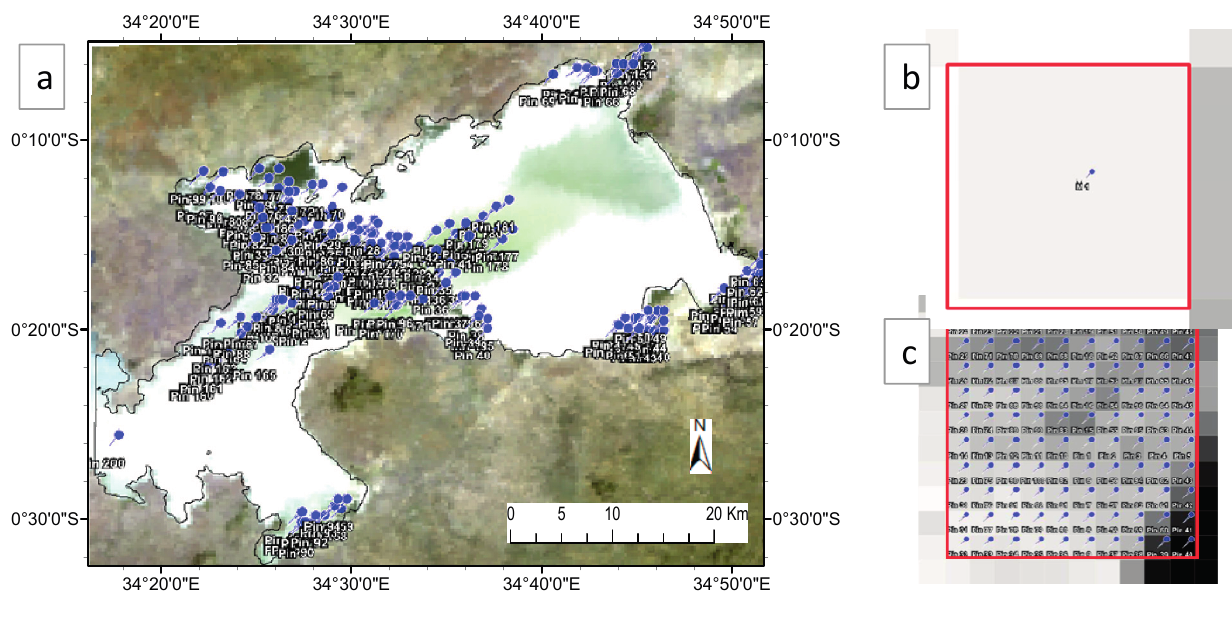
Figure 2. ( a ) Location of the 200 selected sample pixels for the image pair acquired on 15 December 2010, ( b ) A close-up MERIS (300 m) pixel, (c ) Corresponding 100 Landsat-7 ETM+ (30 m)